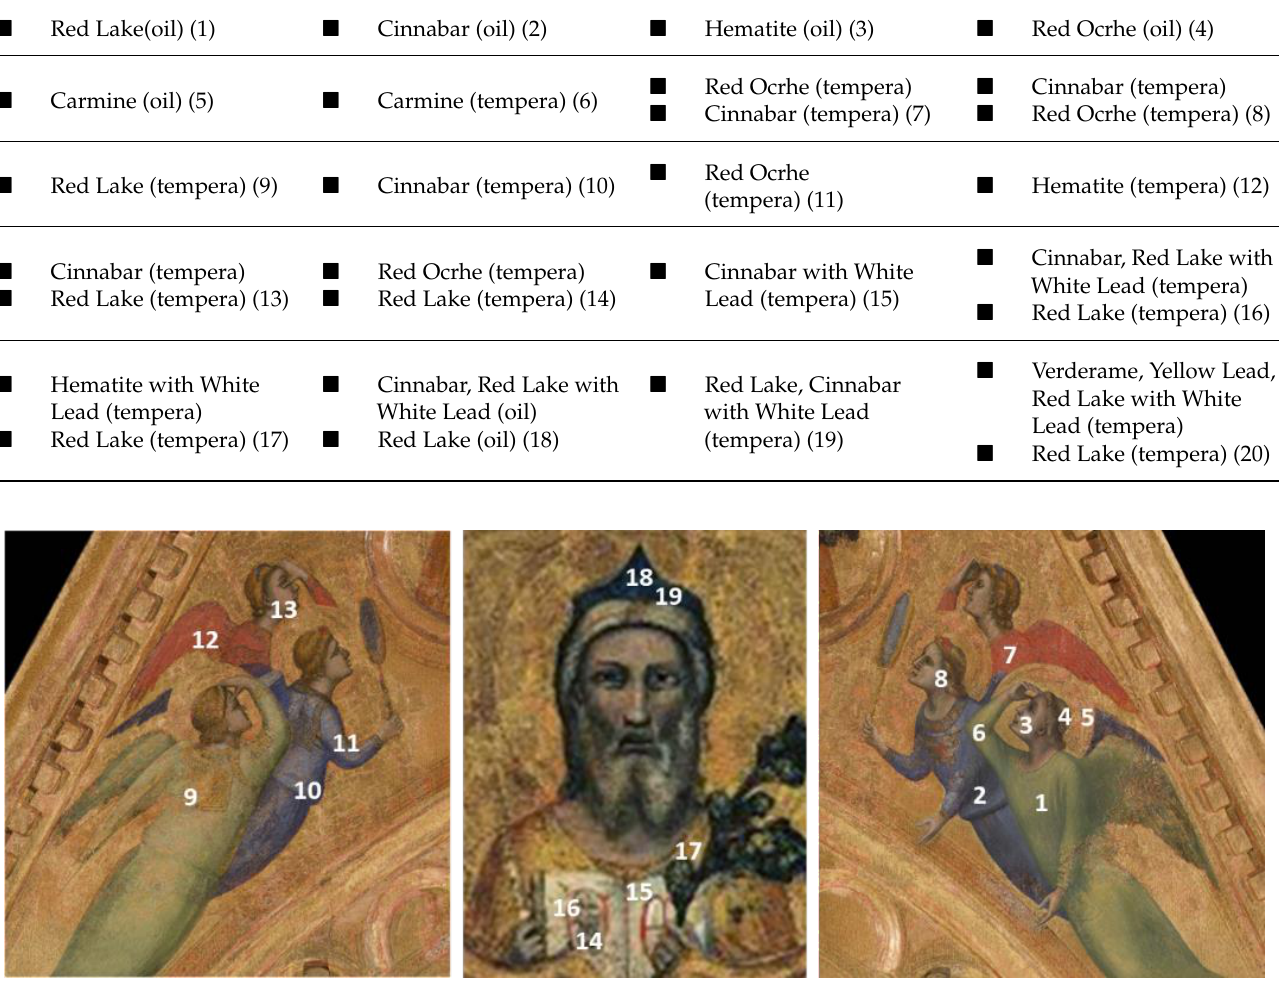
Figure 2. Location of the isolated XRF spectra collected outside the mapped area. The numbers refer to Table 2. The choice of these points follows the twofold purpose to verify hypotheses from previous studies [15,46,48] and, if possible, to gather new insights into the gable’s features. Since the right part was supposed to be more affected by restorations with respect to the left one, the same tones have been collected on both groups of angels to compare the used pigments. Moreover, the book held by God has been investigated because the authenticity of the letters typed on the pages is still debated. The details of the points where the spectra have been detected are listed in Table 2 and can be visualized in Figures 1 and 2. Points from 20 to 23 have been collected within the scanned region to guarantee a connection between the punctual and mapping XRF acquisition in this validation